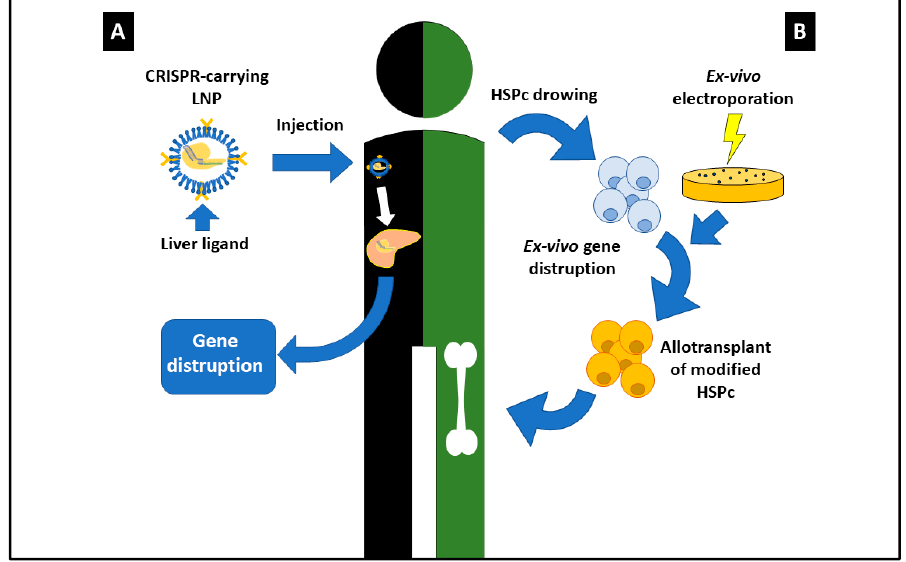
Figure 2. In vivo CRISPR applications. The ( A ) part of the figure represents a scheme of CRISPR/Cas9 complex incapsulated into Lipid Nanoparticles (LNPs). The LNPs are coated with apolipoprotein E (apoE) which will lead the particle into the liver. After intravenous administration, the complex reaches the liver and is taken by the hepatocytes through the interaction with apolipoprotein E. Then CRISPR/Cas9 is released and leads to double strands breaks in the gene which will lose function. In the right side of figure ( B ) is depicted the method for the knockout of the BCLA11A promoter in β -thalassemia. After isolation of hematopoietic stem and progenitor cells (HSPc) from the patient, CRISPR/Cas9 complex has been inserted in these cells ex vivo through electroporation. The cells in which the gene loses its function are reimplanted into the patient. These cells will colonize the bone-narrow without producing BCLA11A which causes the disease.